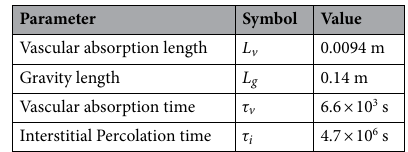
Table 2. Baseline values of length and time scales.